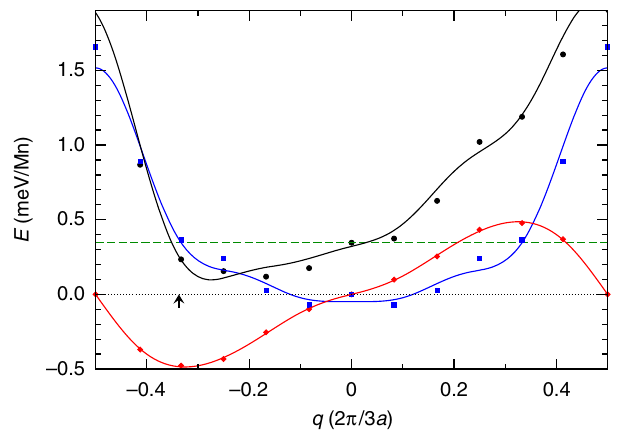
Fig. 4 Results of DFT calculations. Total energy of AFM ordered MnO 2 chains on Ir(001) where the spin directions from chain to chain rotate by an angle of 3 a Ir . The spins form a cycloidal spin spiral propagating perpendicular to the chains with the rotation axis parallel to the chain direction. The contribution from symmetric exchange interaction is shown by blue squares, from the DMI by red diamonds, and from the magneto- crystalline anisotropy by the dashed line. The sum of these terms is marked by black circles. The blue line is a fi t of the symmetric exchange interaction with cos (2 nq ), likewise the DMI was fi tted (red line) with sin (2 nq ), both up to n =